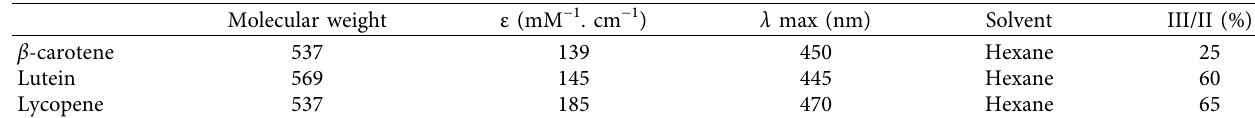
Figure 2: Spectra of (a) pure standards of β -carotene, lutein, and lycopene (solutions 1–3 of Table 2 and (b) mixtures of standards (solutions 4–13 of Table 2). Calculation of %III/II as indication of spectral fine structure is presented for lycopene spectra (%III/II � III/II × 100). Table 1: Carotenoid absorption data from literature [3,